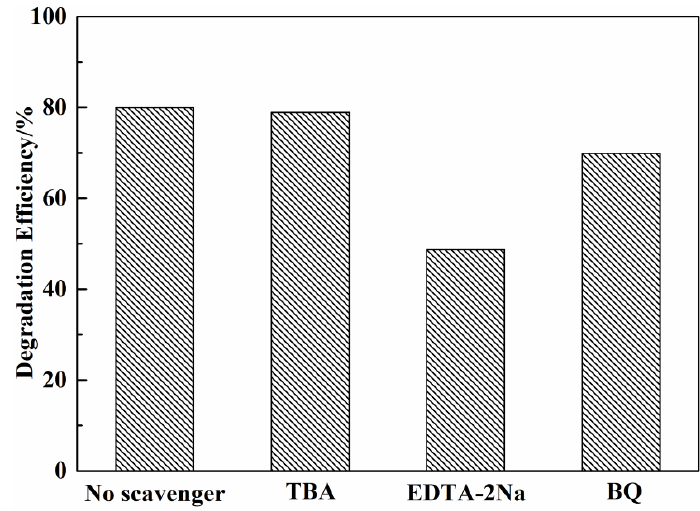
Figure 9. Trapping experimental results of active species for the photocatalytic degradation of RhB by m-CN/KA-4 composite under 180 min visible light illumination.